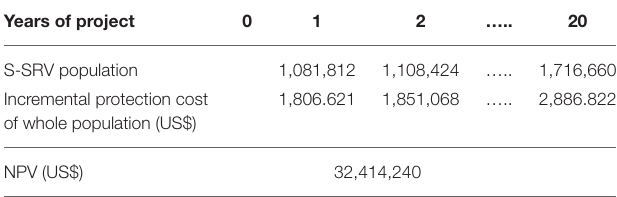
TABLE 7 | Population protection against